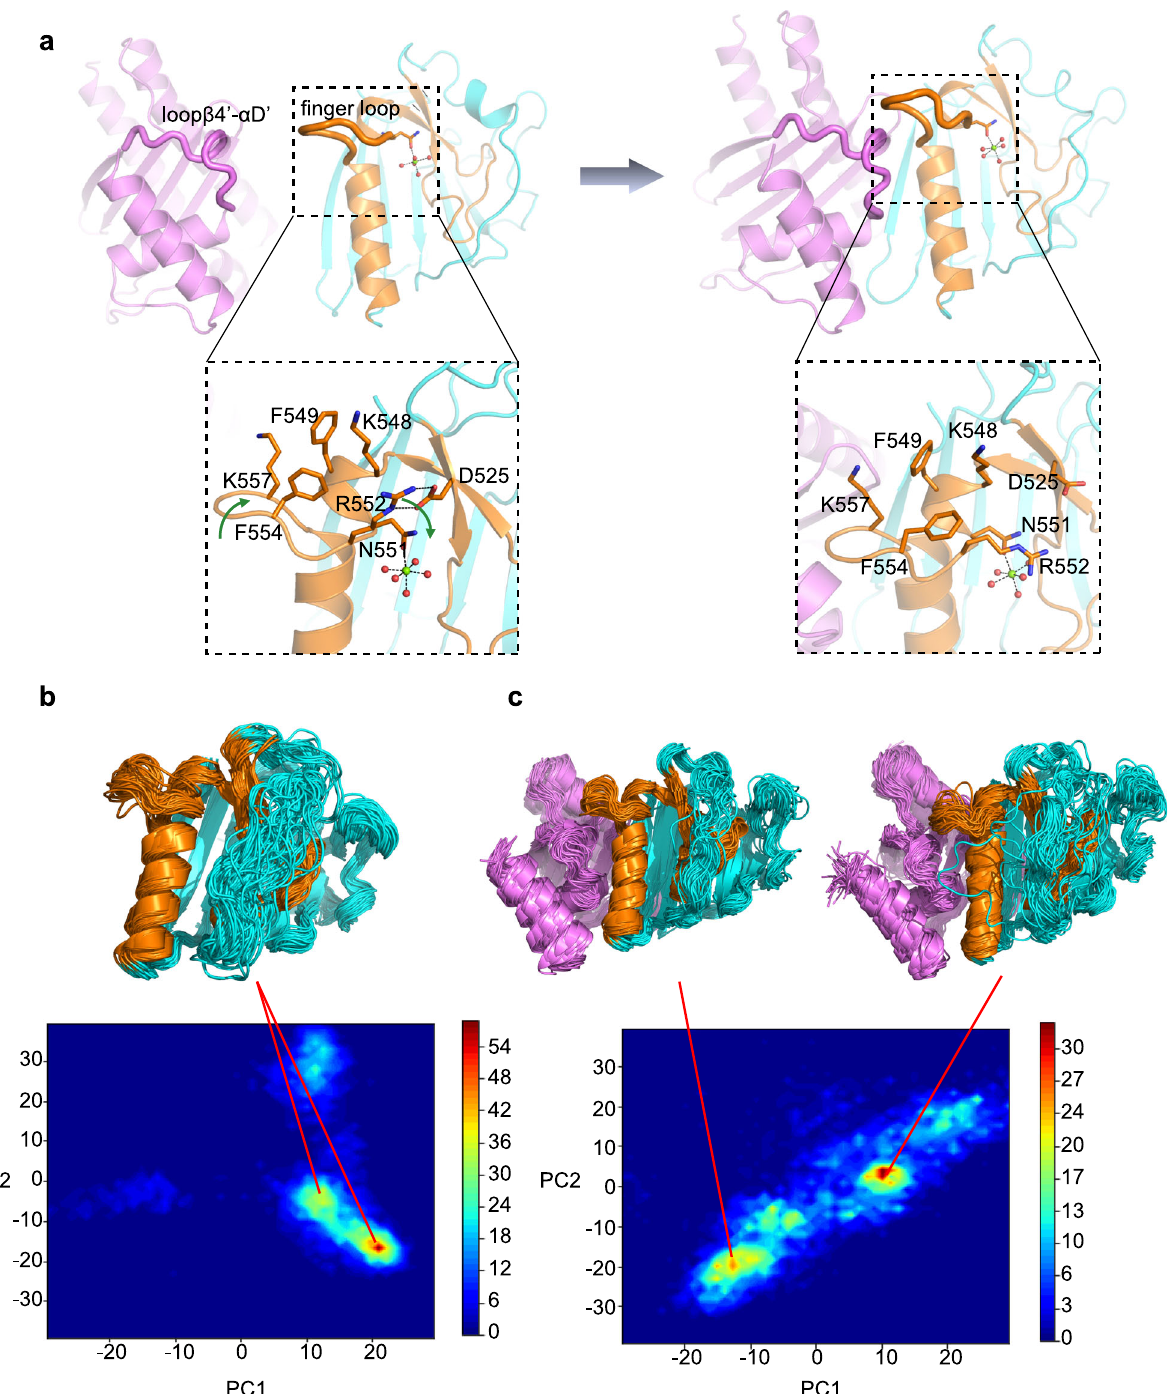
Fig. 3 | Conformational changes of EsaDc in MD simulations. a Conformational changesof fi ngerloopduringthebindingprocessofEsaGtoEsaDc.EsaGiscolored in purple; the ββα -metal fi nger is colored in brown and the rest part of EsaDc in cyan.Theresiduesonandaroundthe fi ngerlooparehighlightedinexpandedview with their side chains shown asstick presentation. The magnesium ion is shown as